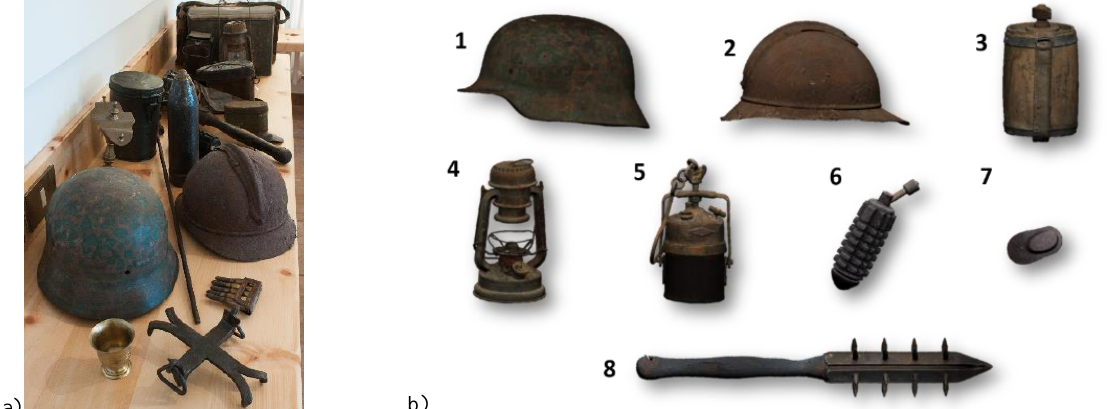
Figure 6. (a) The WWI findings. (b) 3D models of war findings: 1) Austro-Hungarian helmet, 2) Italian helmet, 3) Water bottle, 4) Ditmar lamp, 5) Osmeka DB lamp, 6) Hand grenade, 7) Reinforced glasses, 8) Spiked club. All models are freely accessible on the web in the Europeana (http://www.europeana.eu/portal/en) and FBK-3DOM (http://3dom.fbk.eu/repository/portal/portal.html)